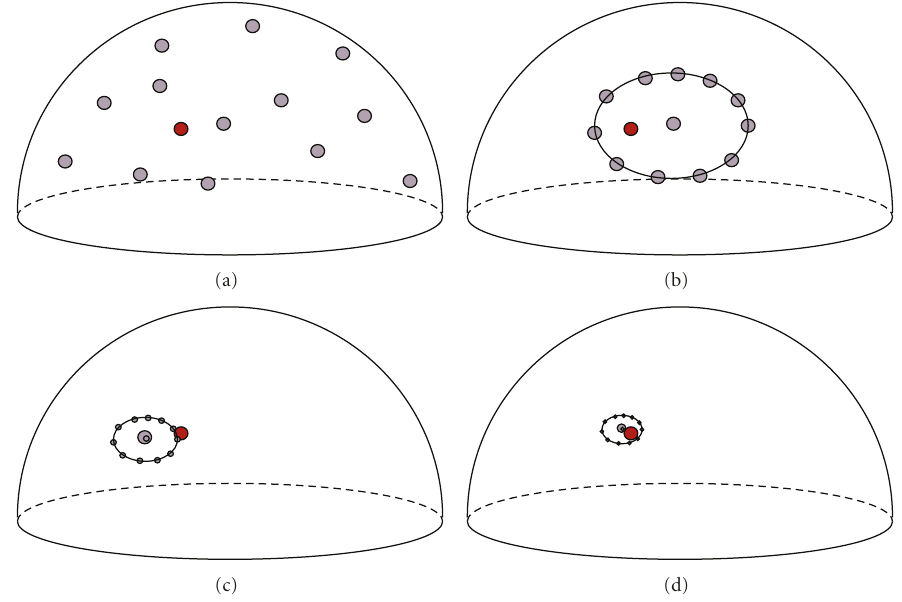
Figure 1: Illustration of progressive quantization with a local codebook, in this case a ring as described in more detail in Section 4. Points on a sphere are used for visualization purposes. (a) Quantization with a base codebook to choose the starting point for progressive refinement. (b) Quantization with a ring codebook centered around the previously chosen codebook point. (c) Next level of refinement with a smaller ring, centered around the previously chosen codebook point. (d) The process repeats with a smaller ring until the desired performance is reached.